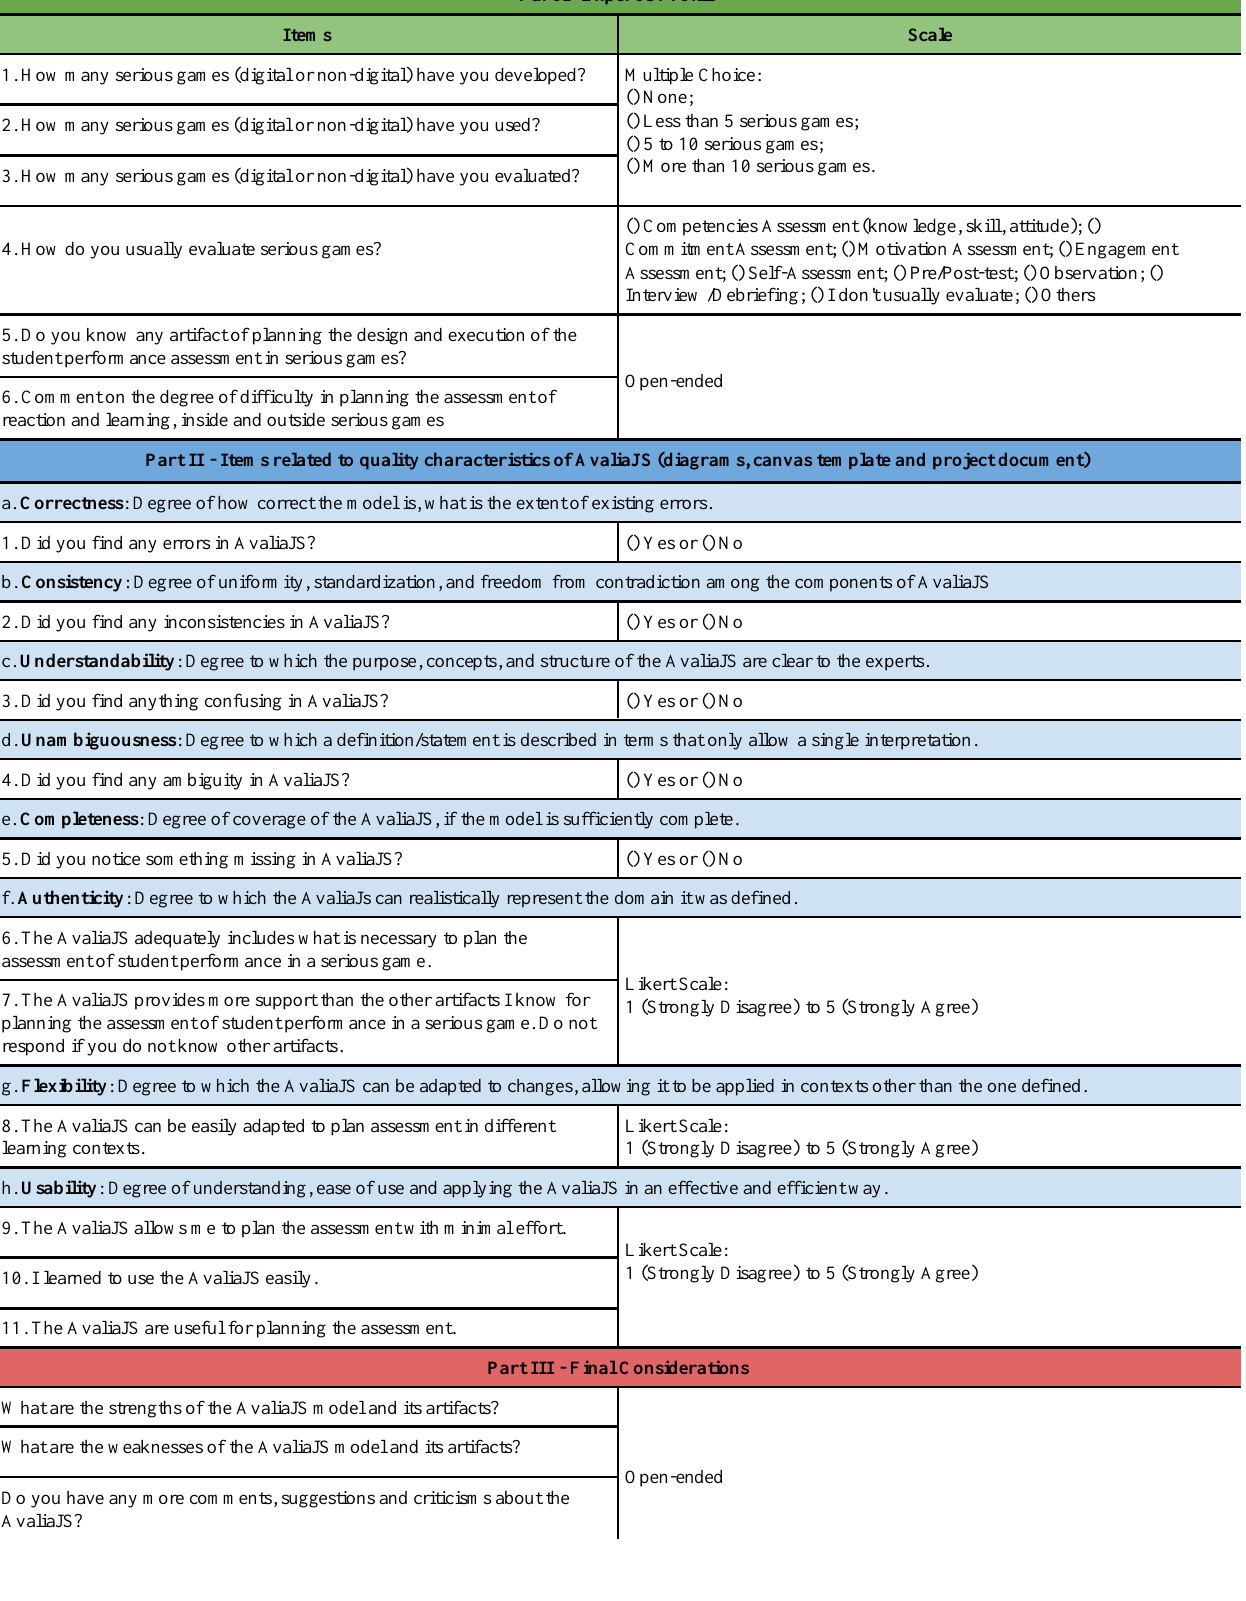
Table 4. Questionnaire of quality evaluation of the